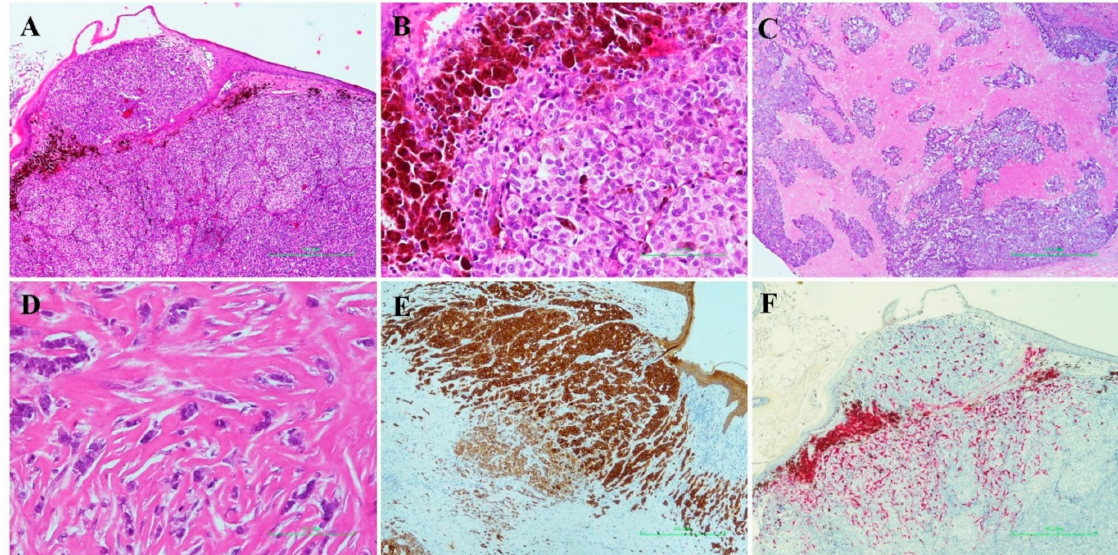
Figure 1. Histological and immunohistochemical features of case 1 . ( A ) Low power view (2 × ) demonstrating a neoplastic proliferation growing in irregular nests and sheets beneath a thinned epithelial layer. ( B ) The neoplasm showed a nevoid appearance with abundant brown melanin pigment surrounding neoplastic cells with epithelioid morphology. ( C ) The deeper portion of the neoplasm resembled an invasive breast carcinoma with abundant tumor necrosis and no pigmentation. ( D ) Some tumor areas showed a lobular-like tumor growth constituted of single files of tumor cells loosely dispersed throughout fibrous matrix. ( E ) By immunohistochemistry, neoplastic cells showed diffuse immunoreactivity for cytokeratin AE1-AE3. ( F ) By contrast, HMB 45 staining was negative in neoplastic cells and highlighted only the colonizing